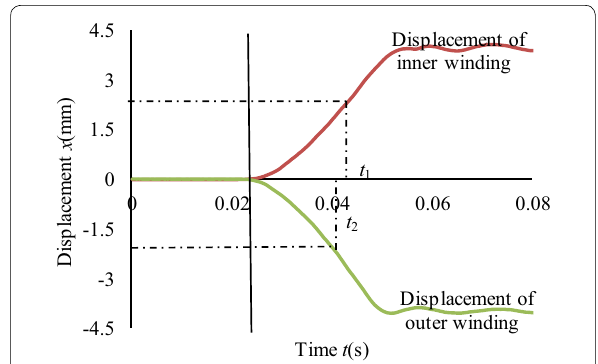
Figure 24 Rapid response of double push rods